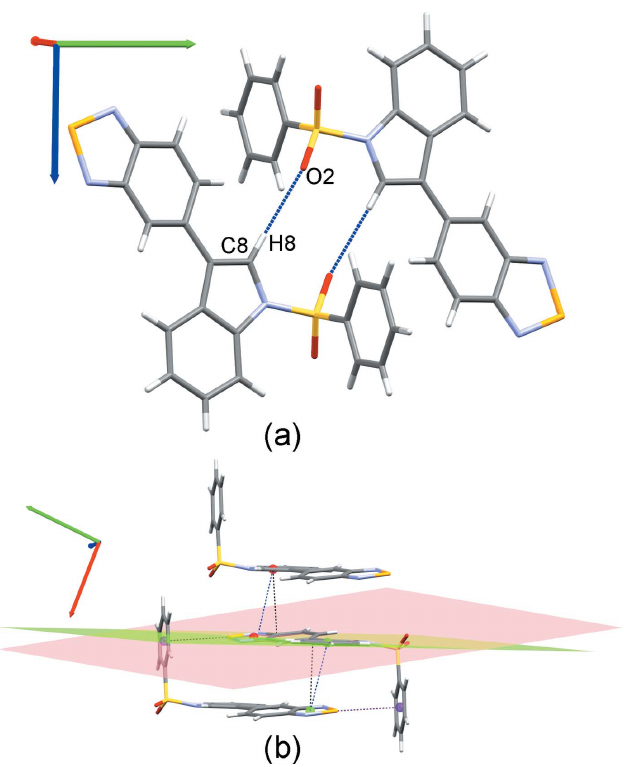
Figure 4 Supramolecular organization of p-bSe: ( a ) hydrogen-bond interactions; ( b ) (cid:2) -stacking interaction between the benzoselenadiazole group and the indole groups (centroids in red: Se/N1/C1/C6/N2 and N3/C7–C10 and centroids in green: Se/N1/C1/C6/N2 and C9–C14) as well as chalcogen– (cid:2) interactions (in purple).